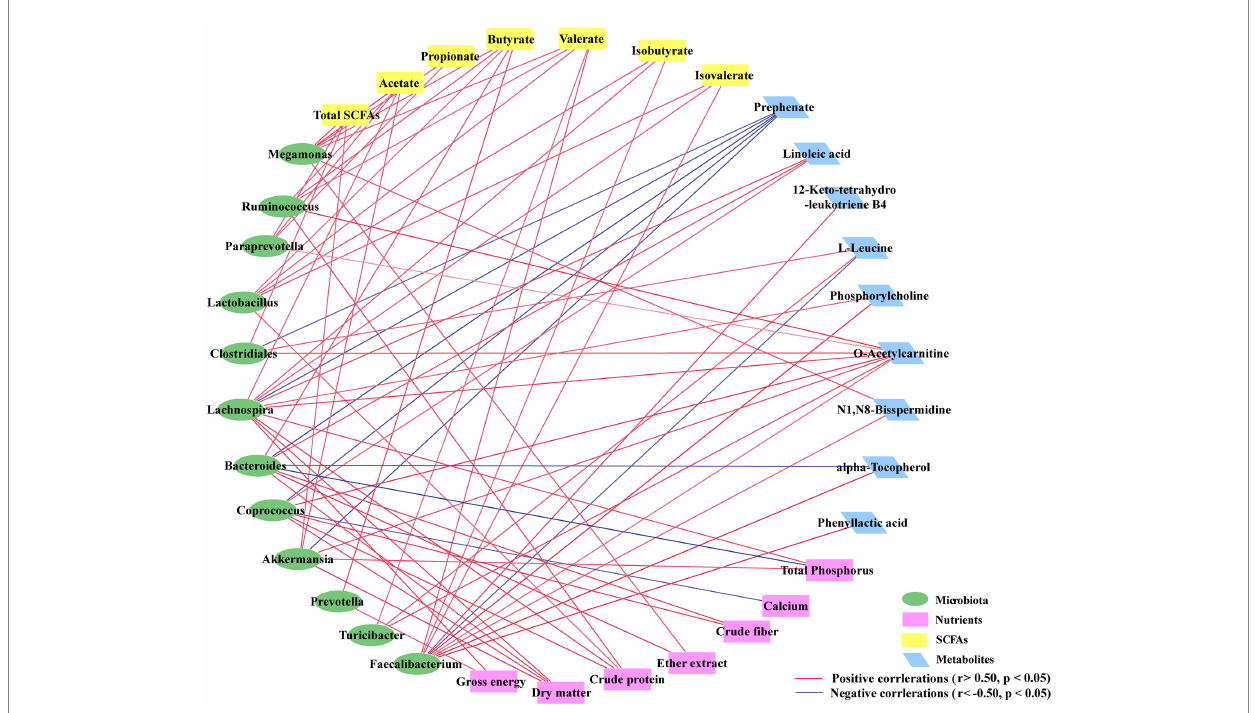
FIGURE 5 Correlation network analysis among the cecal microbiota (at the genus level), differentially expressed metabolites and apparent digestibility of nutrients. Each line has an absolute Spearman rank correlation; red lines represent positive correlations ( r > 0.50, p < 0.05), and blue lines represent negative correlations ( r < − 0.50, p <